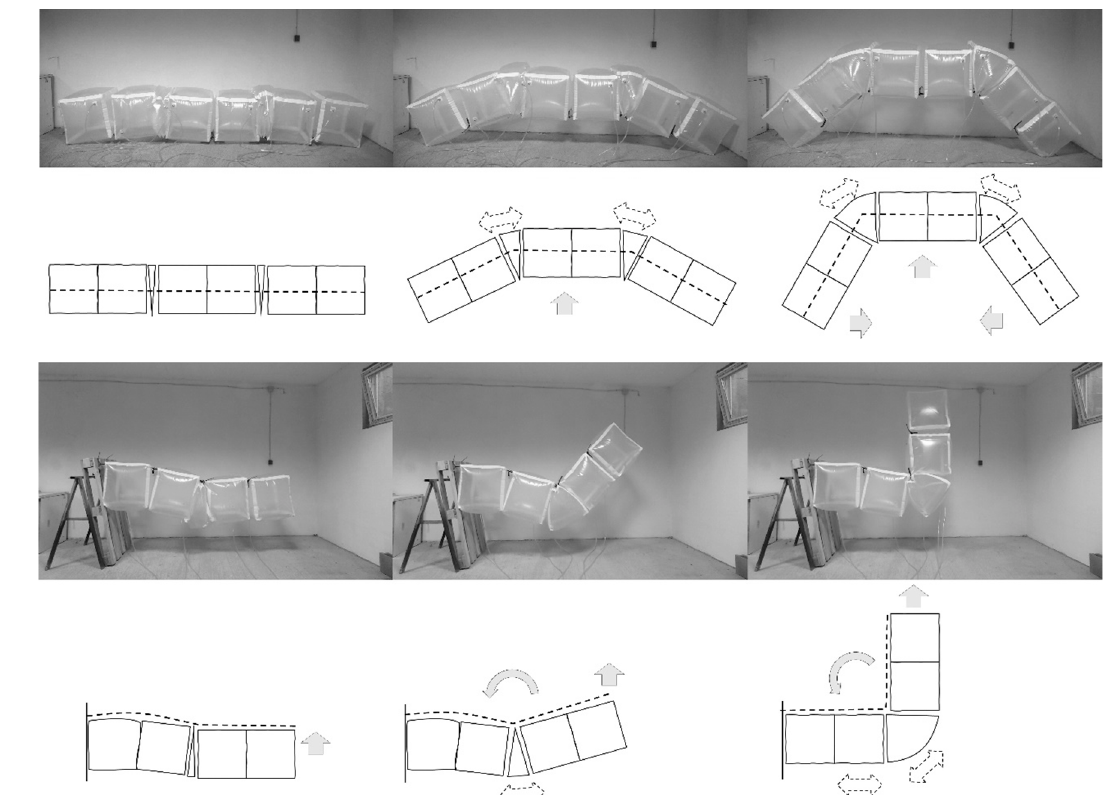
Figure 9. Basic body plan type D: ( a ) self-erecting frame; ( b ) cantilever.